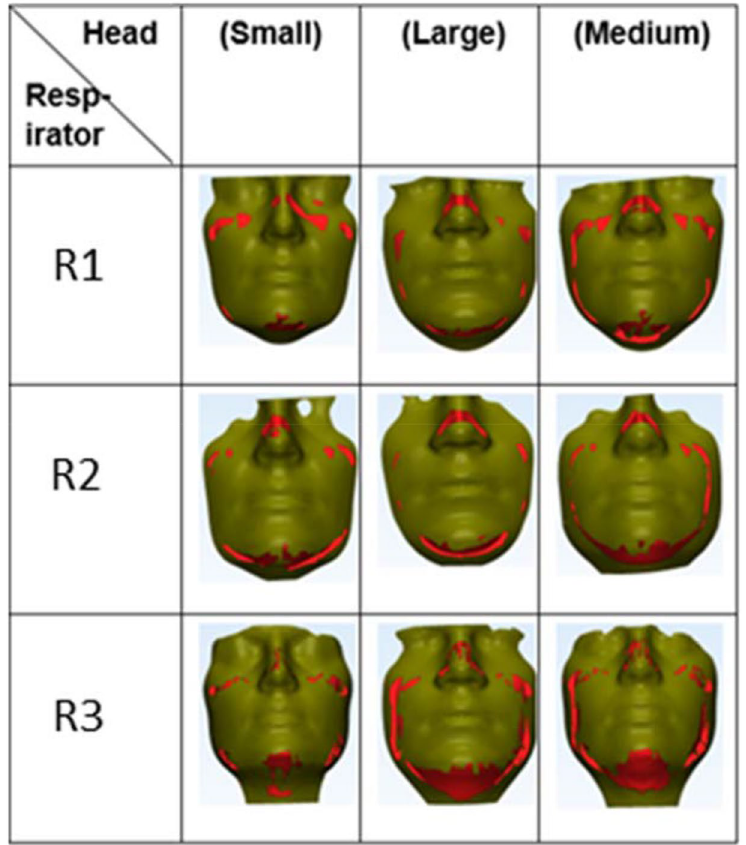
Figure 5. Anatomical leakage sites. Red zones are regions of contact between face and the respirator. The leakage sites are the gaps between the red